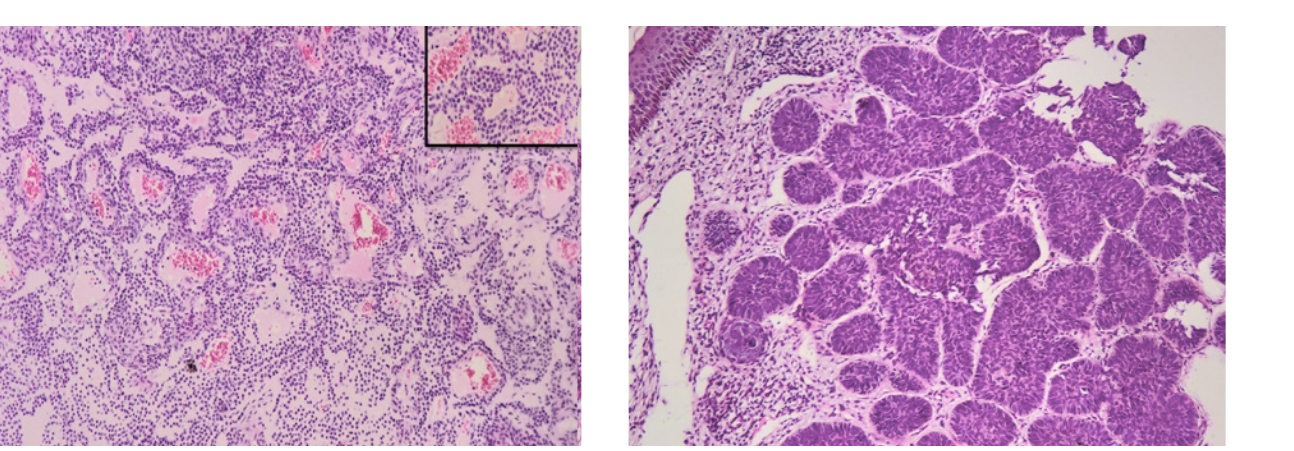
Figure 3: Glomus tumor (Glomangioma). Vascular spaces are surrounded by layers of glomus cells. (HE stain; X40). Inset showing higher power view of the same.